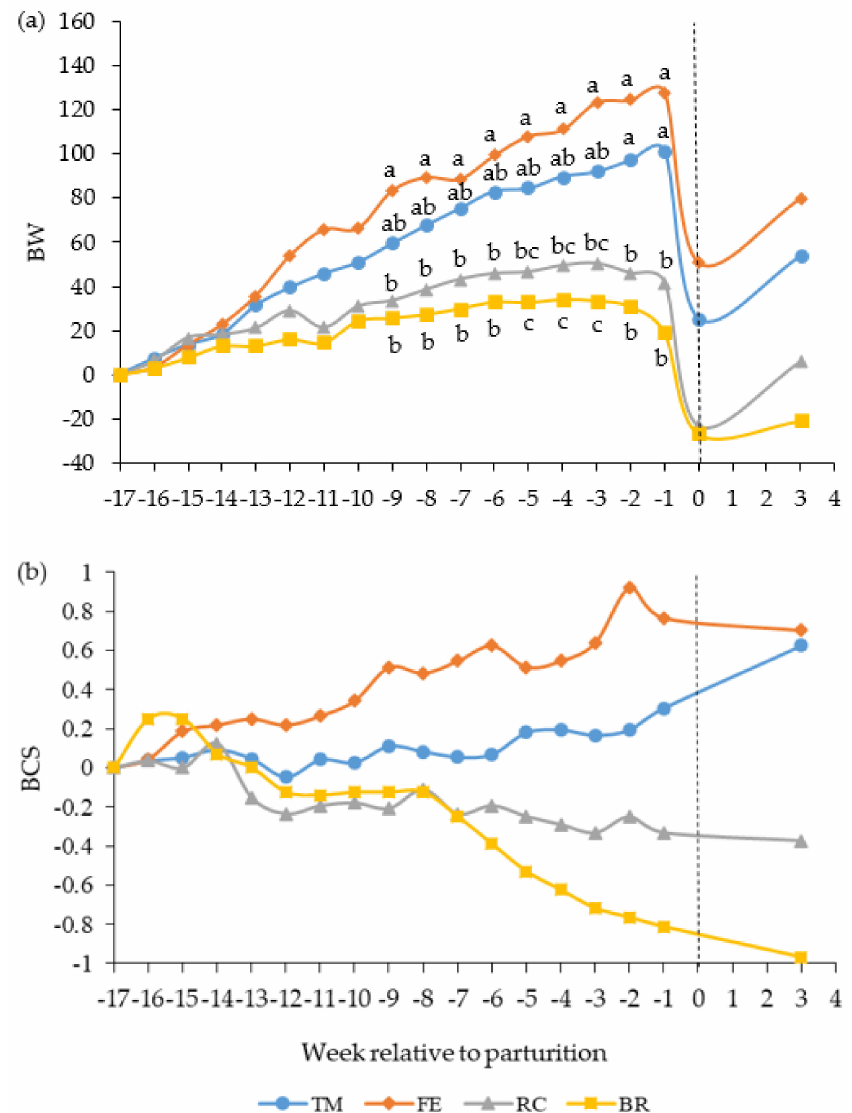
Figure 1. Change in ( a ) body weight (BW, kg) and ( b ) body condition score (BCS, scale 1 to 9) in beef cows fed timothy-meadow fescue silage (TM), festulolium silage plus urea mix (FE), reed canarygrass silage (RC), or barley straw plus urea mix (BR) ad libitum prepartum, including additional supplementation of rapeseed meal for cows on the BR diet. All cows received the same timothy grass silage ad libitum postpartum. Prepartum n = 8–9 cows / diet in each data point and postpartum n = 8 cows / diet in each data point. Time is expressed in weeks in relation to parturition (week 0) and the dashed line indicates time of calving. The interaction of diet × week was significant ( p < 0.001) for the change in BW and tended to di ff er ( p = 0.06) for the change in BCS. a,b,c items lacking a common superscript di ff er among weeks ( p <